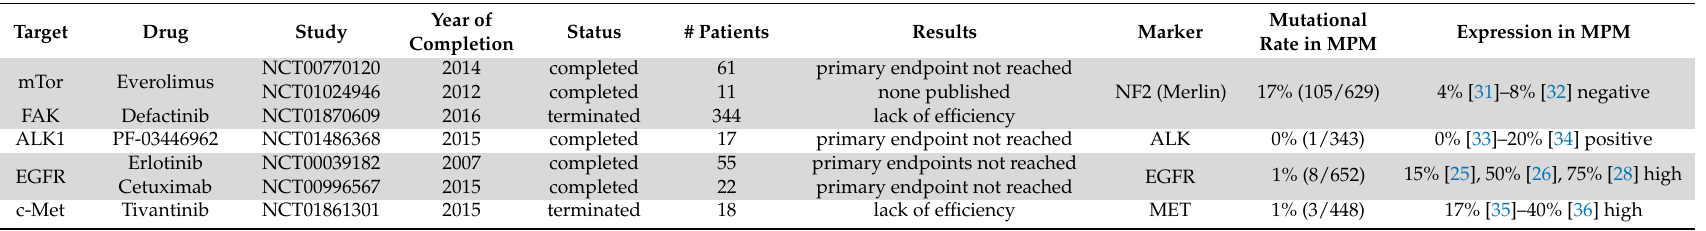
Table 1. Selection of finished studies using targeted therapy approaches in malignant pleural mesothelioma (MPM). The mutational rate in MPM was taken from the cosmic database. Data on expression were taken from indicated